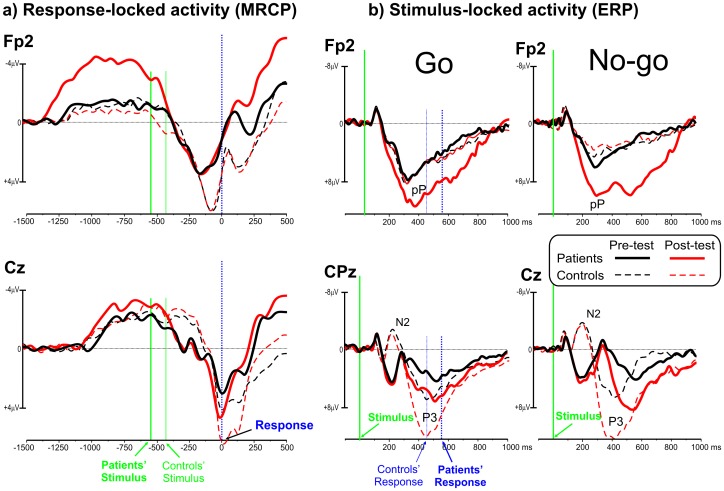
Grand average of the movement- and event-related potentials waveforms.a) MRCP waveforms (response-related activity) over the prefrontal lobe (Fp2) and the sensorimotor cortex (Cz). Time zero represents the response onset. Vertical green lines represent the median time of stimulus onset in the two groups. b) ERP waveforms (stimulus-related activity) over the prefrontal lobe (Fp2) and the sensorimotor cortex for both Go (CPz) and No-go (Cz) stimuli. Time zero represents the stimulus onset. Vertical blue lines represent the median time of response onset in the two groups.